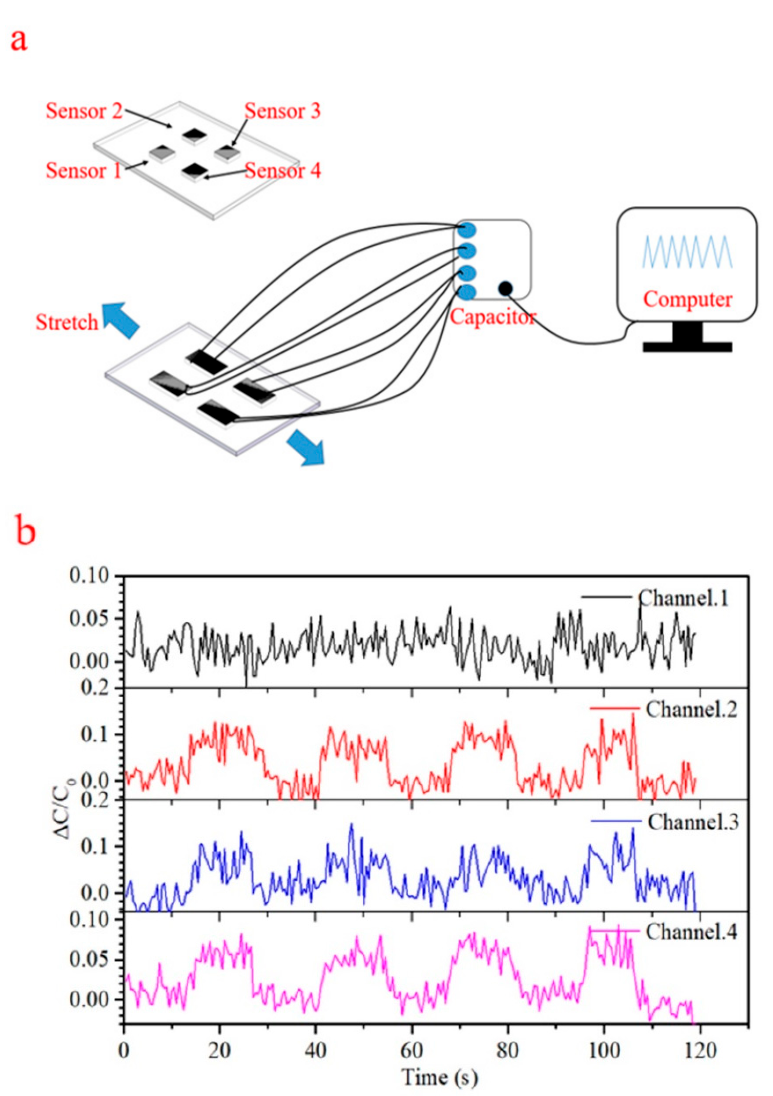
Figure 8. ( a ) The test circuit diagram of a four channel sensor integrated elbow band. ( b ) Capacitive traces demonstrating monitoring of elbow motion during flexion with the band.